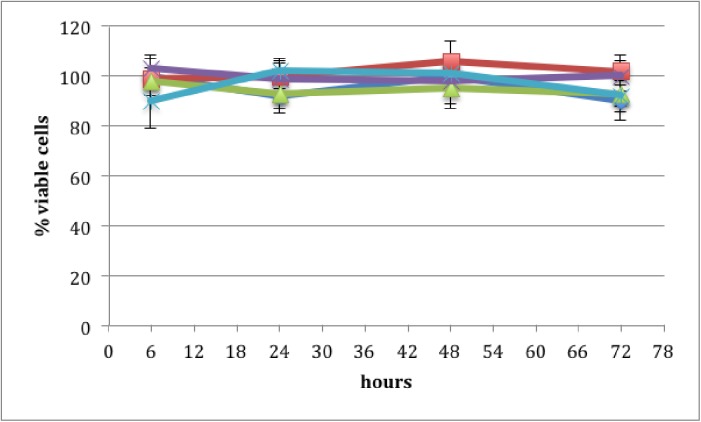
Antiviral EC50 curves covering the range 0.001, 0.005, 0.01, 0.5, 1 μg mL-1 (n = 3 ± SD).